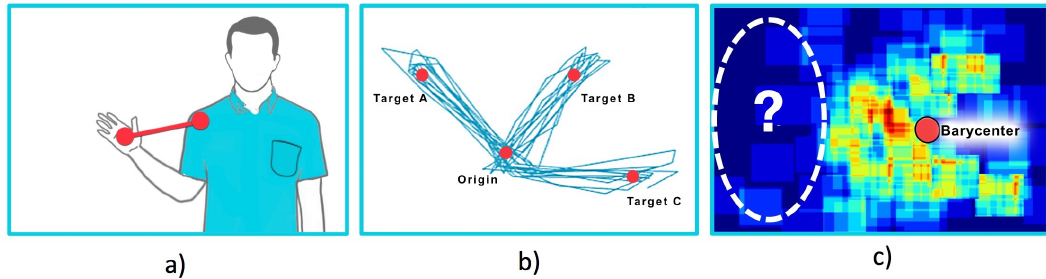
Figure 3. ( a ) Abduction–Adduction exercise scheme; ( b ) Hand trajectory in ShelfCans game; ( c ) Heatmap to detect neglected areas.